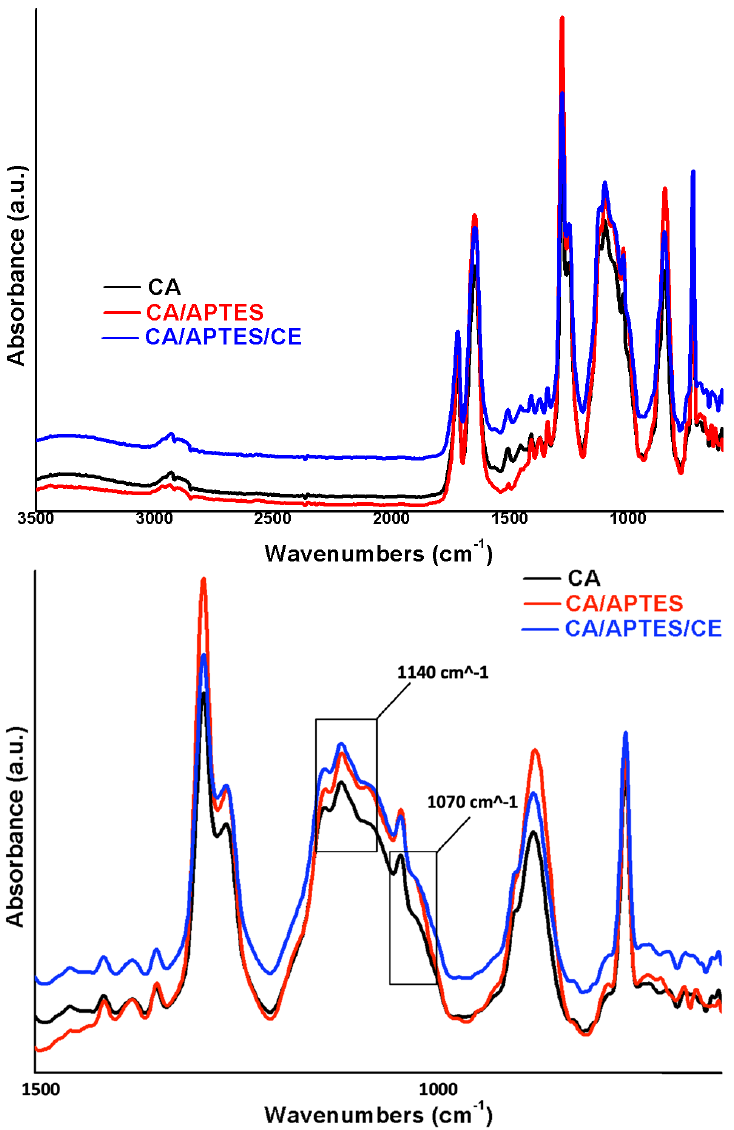
Figure 3. Fourier transform infrared spectroscopy spectra (FT-IR) of synthesized membranes CA, CA/APTES, and CA/APTES/CE, respectively.